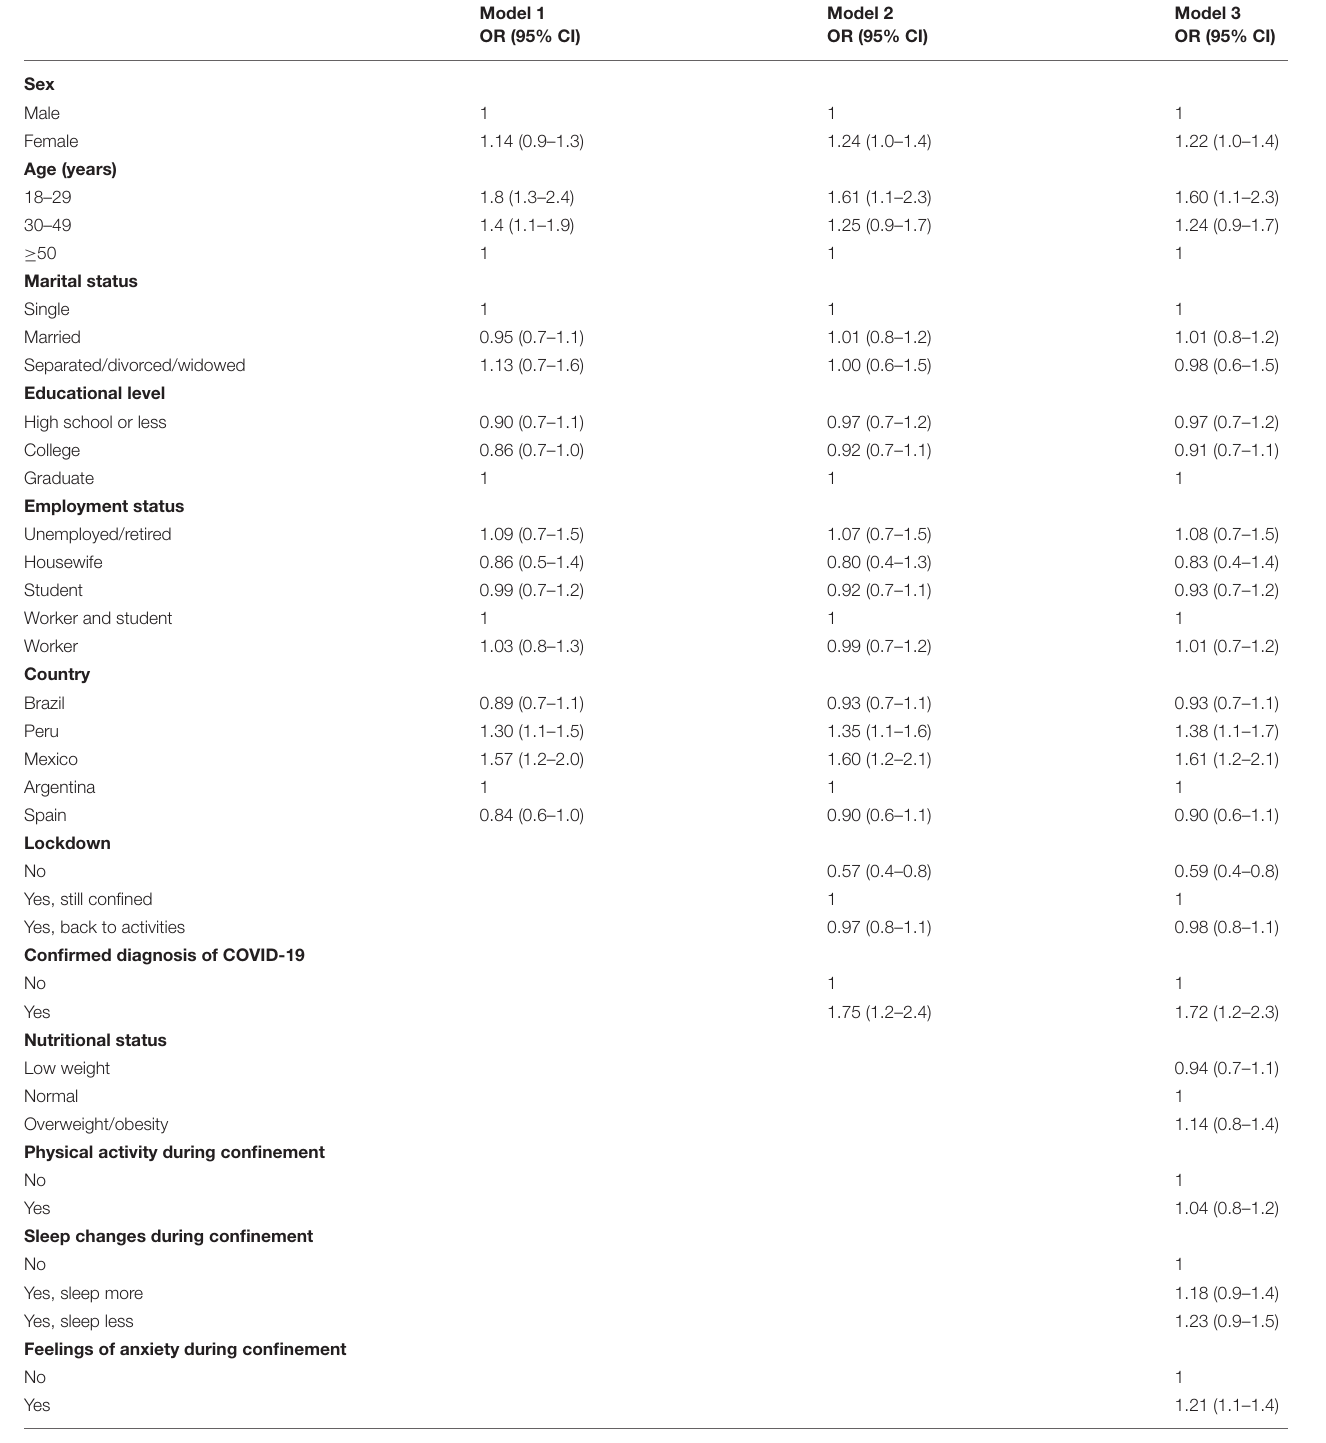
Model 2 adjusted for sociodemographic variables, confinement and confirmed diagnosis of COVID-19; Model 3 adjusted for sociodemographic, confinement, COVID-19 diagnosis, lifestyles variables (nutritional status, physical activity, and sleep changes during confinement), and anxiety during confinement.